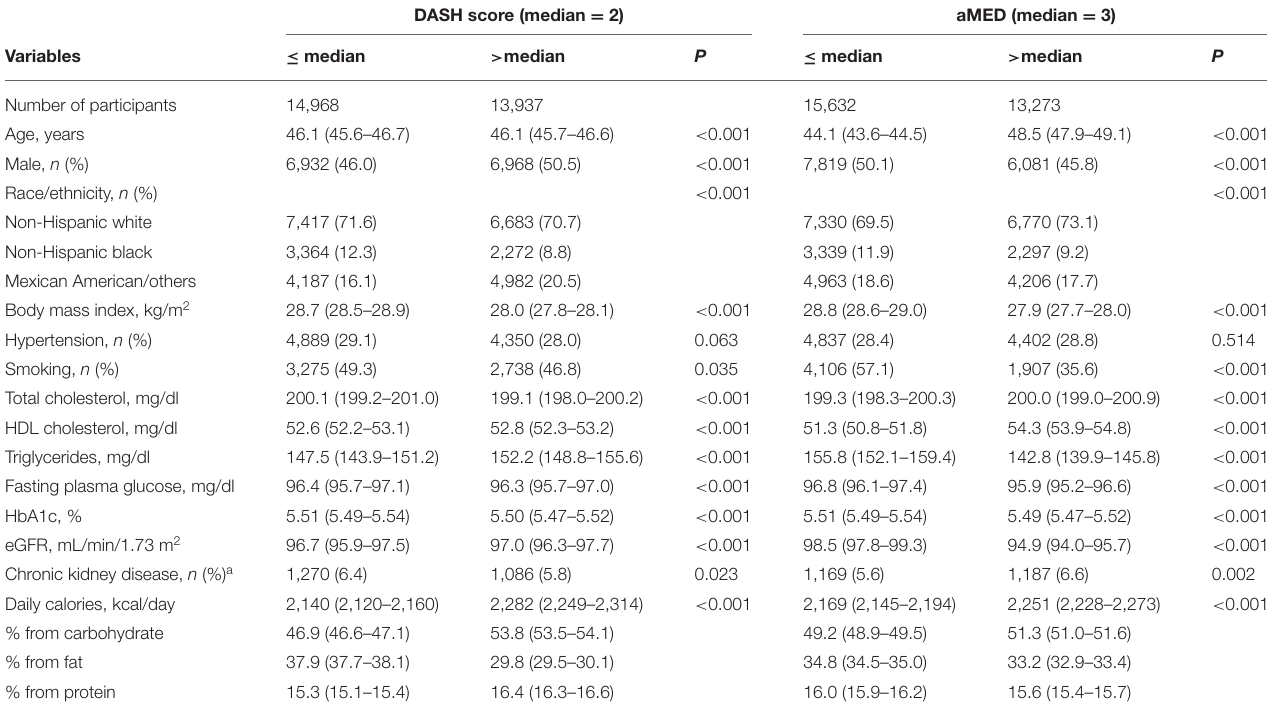
TABLE 2 | Characteristics of study participants according to the DASH score and the aMED. DASH score (median =